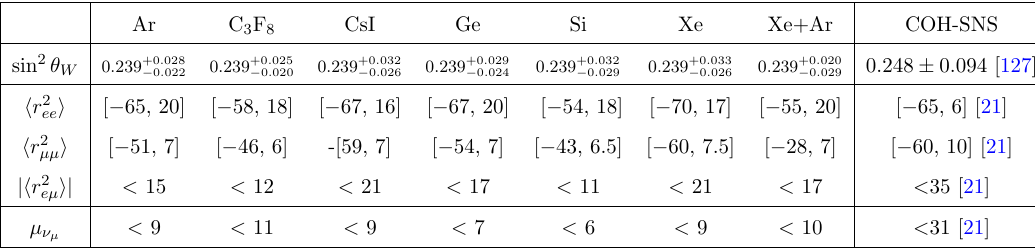
1 : 64 (cid:27) ), neutrino (cid:6)